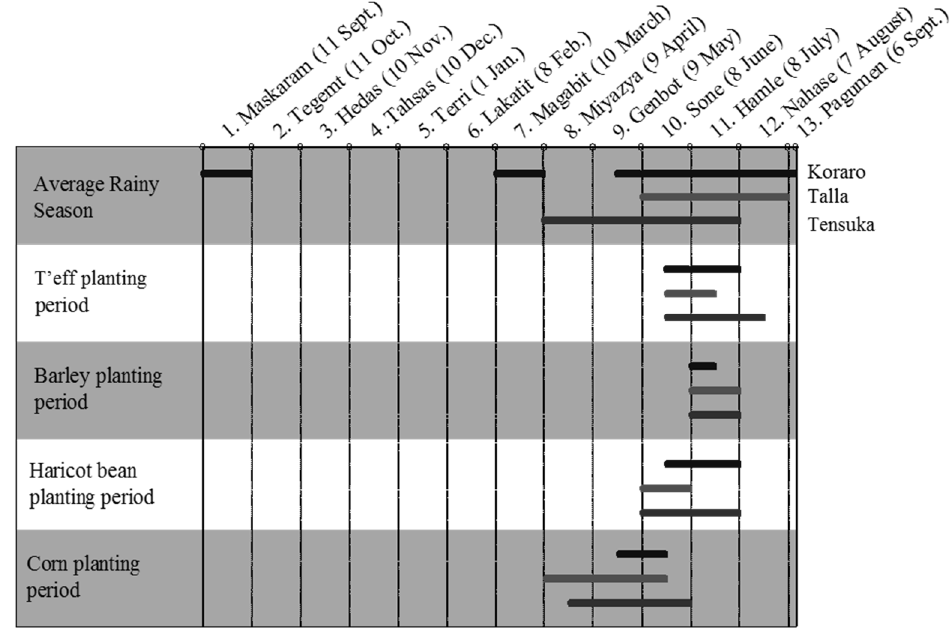
Figure 7. Planting Periods for main crops, by Kushet.